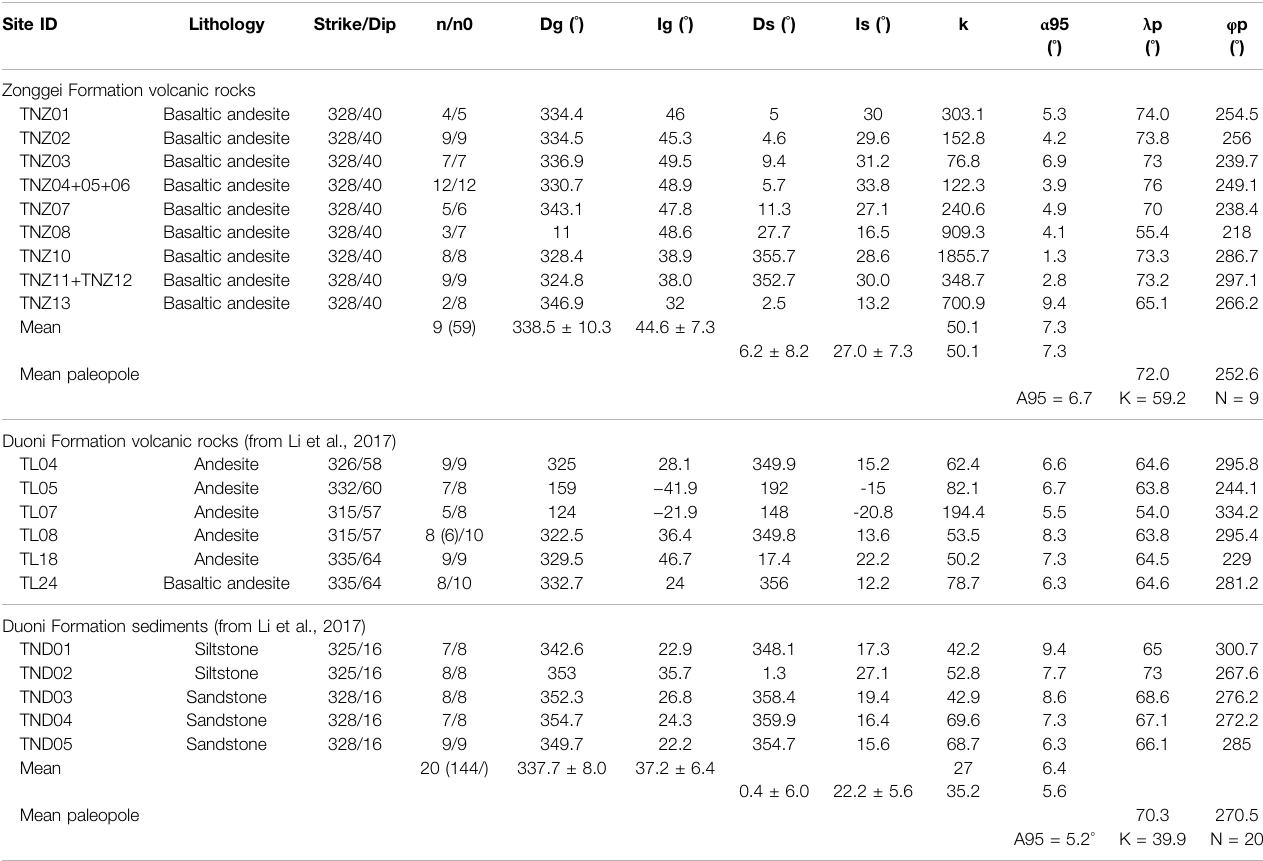
TABLE 1 | Summary of all ChRM group-means of the Zonggei Fm. volcanic rocks and selected results from the Duoni Fm. volcano-sedimentary rocks. Site